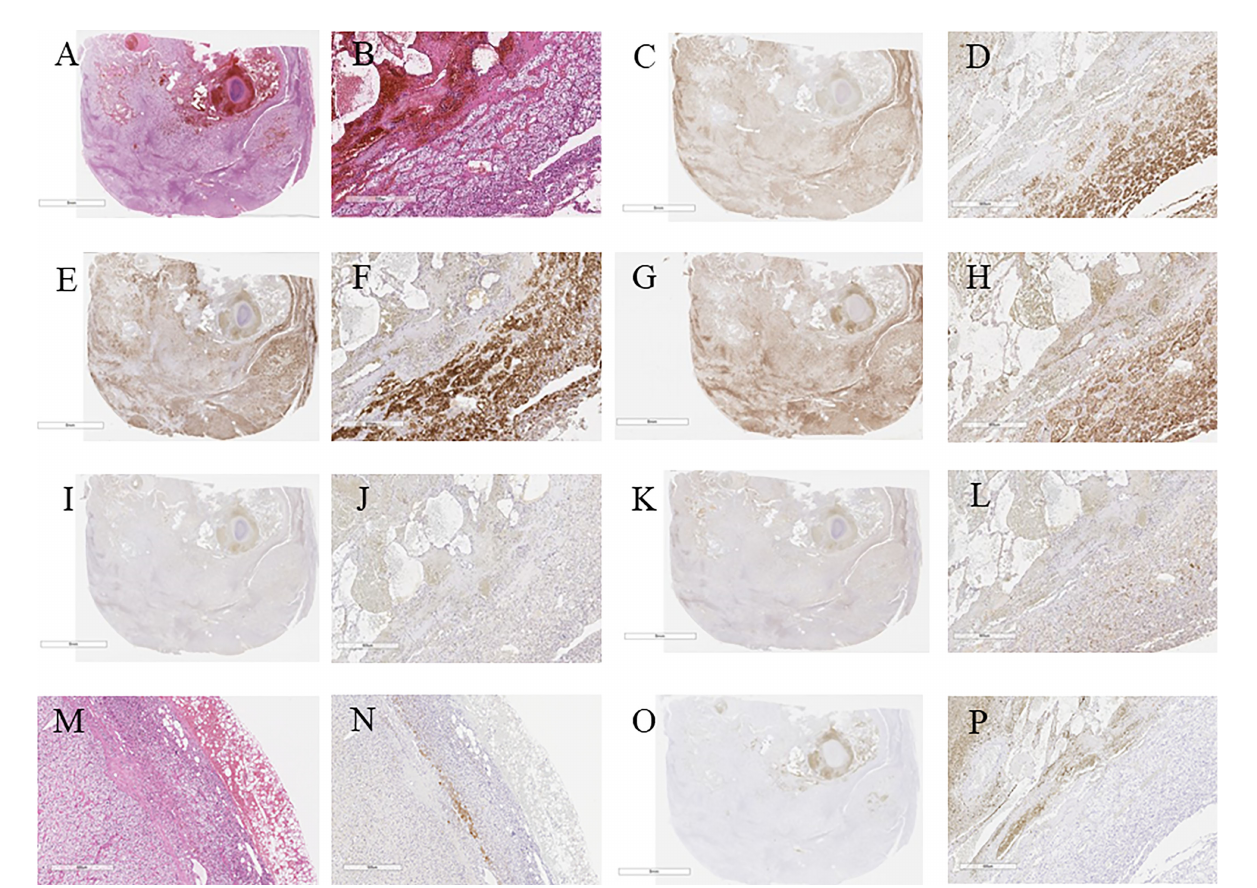
FIGURE 3 | (A) Hematoxylin and eosin immunostaning. (B) Hematoxylin and eosin-stained tumor section on high magni fi cation showing cortical adenoma (40×). (C) c17 immunostaining. (D) c17-stained tumor section on high magni fi cation (40×). (E) HSD3B2 immunostaining. (F) HSDB2-stained tumor section on high magni fi cation (40×). (G) CYP11B1 immunostaining. (H) CYP11B1-stained tumor section on high magni fi cation (40×). (I) HSDB1 immunostaining. (J) HSDB1-stained tumor section on high magni fi cation (40×). (K) DHEA-ST immunostaining. (L) DHEA-ST-stained tumor section on high magni fi cation (40×). (M) Hematoxylin and eosin-stained concomitant adrenal tissue on high magni fi cation (40×). (N) High magni fi cation of DHEA-ST-stained concomitant adrenal tissue on high magni fi cation (40×). (O) CYP11B2 immunostaining. (P) CYP11B2-stained tumor section on high magni fi cation